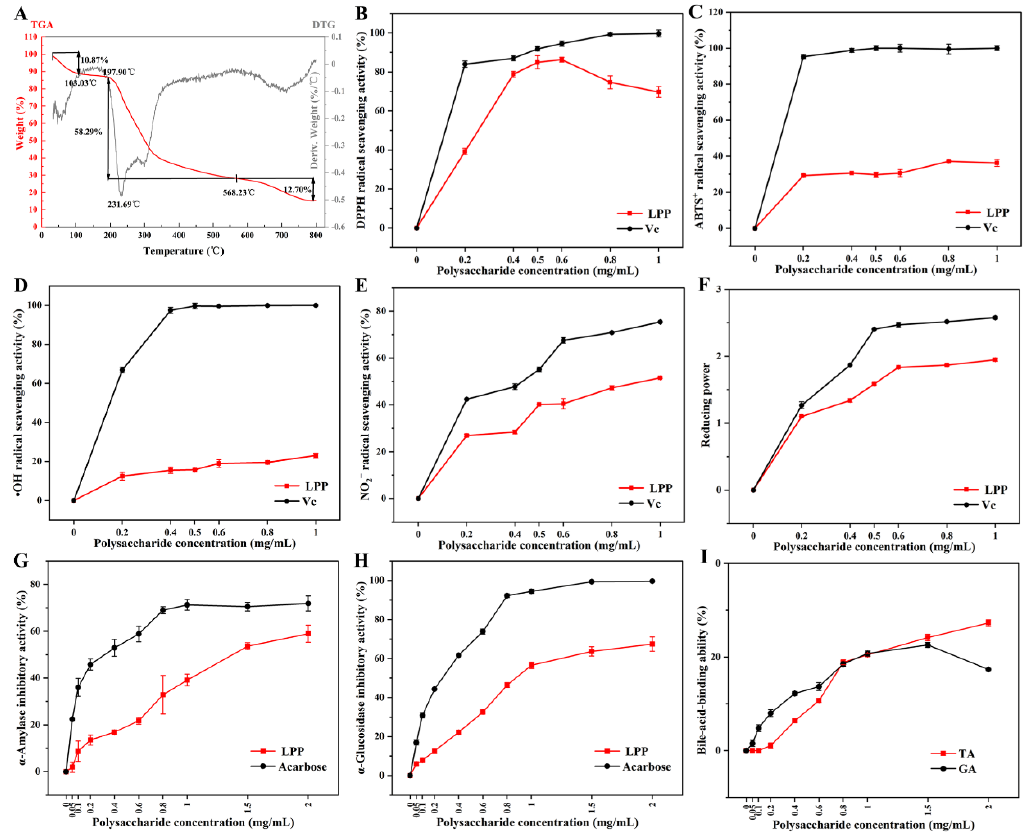
Figure 4. The properties of LPP. ( A ) Thermal properties, ( B ) DPPH radical scavenging activity in